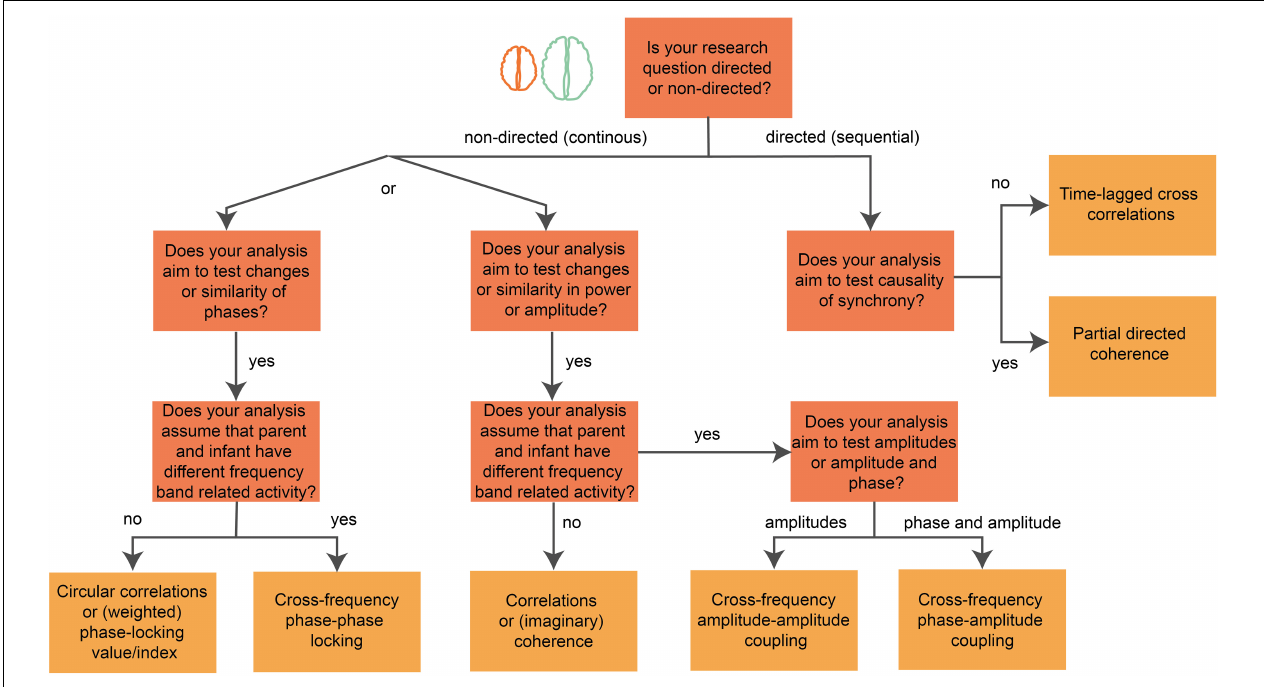
FIGURE 3 | Decision tree of brain-to-brain coupling analysis. Image showing steps of a decision tree for the interpersonal coupling analysis after preprocessing. This flow-chart supports in finding a metric that is in line with the research question. Each dark-orange node represents a question about the research question (e.g., “Does your analysis aim to test causality of synchrony?”), each connection represents the answer (e.g., “yes” or “no”) or shows a choice between options (e.g., “or”), each yellow node represents a single or various coupling metrics (e.g., Partial directed coherence) that are in line with the research question. The decision tree starts at the orange node with the text: “Is your research question directed (sequential: time-lagged or causal) or non-directed (continuous in